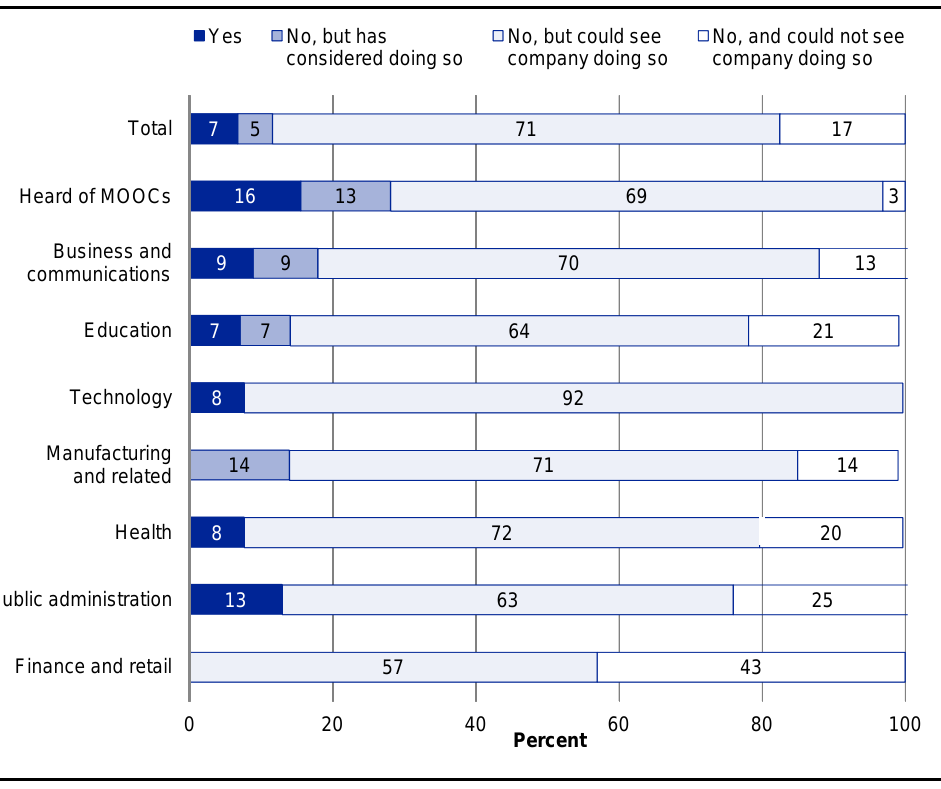
their company using MOOCs for professional